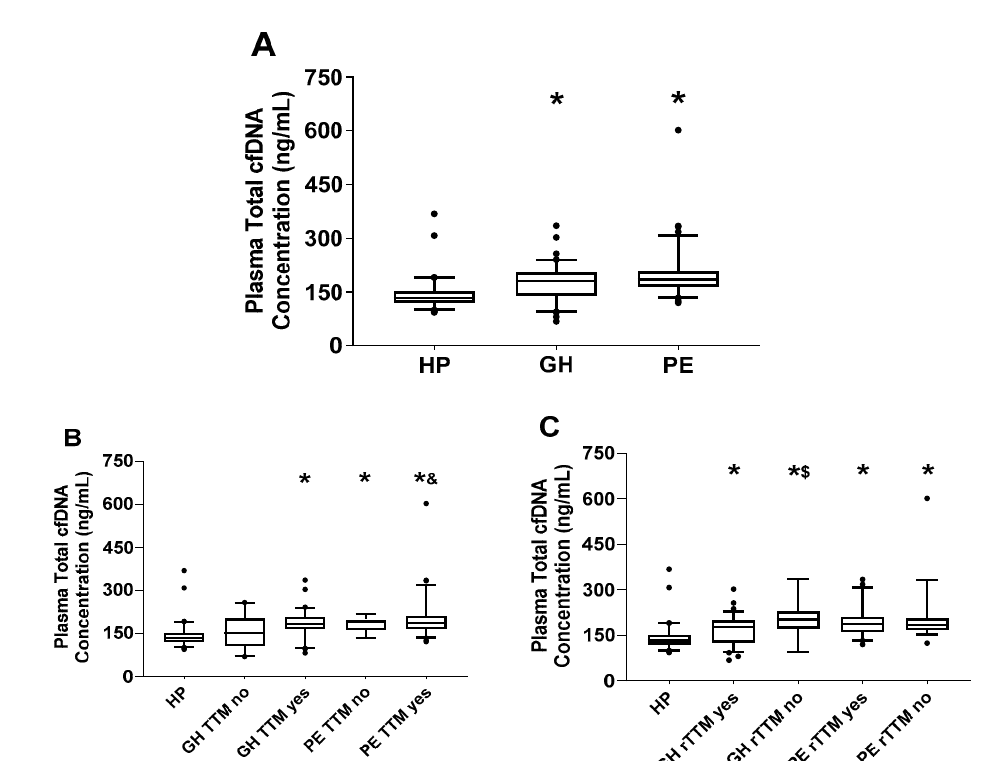
Figure 1. Total cell-free DNA (cfDNA) concentration in plasma of women with healthy pregnancies (HP), gestational hypertension (GH), or preeclampsia (PE) ( A ). Total cfDNA levels in patients prescribed (treatment (TTM) yes) or not prescribed (TTM no) antihypertensive therapy by HDP status, compared to HP ( B ). Total cfDNA levels in women with GH or PE who were treatment-responsive (rTTM yes) versus non-responsive (rTTM no) to antihypertensive therapy, compared to HP ( C ). Box and whiskers are median {interquartile range, 5–95% percentile}. * p < 0.0001 versus HP group and & p < 0.05 versus GH TTM no group based on Kruskal-Wallis test with Dunn’s multiple comparisons correction. $ p < 0.05 versus GH rTTM yes group based on Mann-Whitney test.